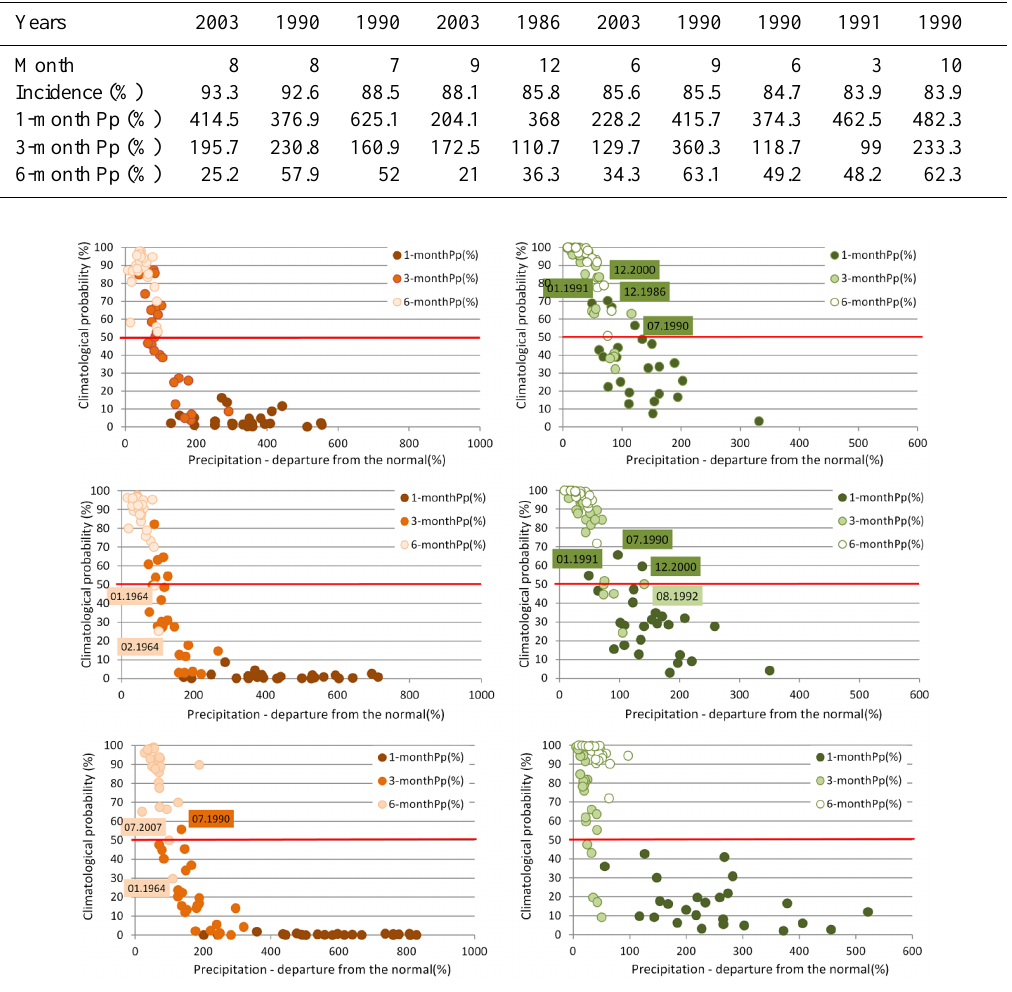
Figure 5. Probability (%) of ending (left) or ameliorating (right) moderate (top), severe (centre) and extreme drought (bottom) events with the highest incidence in the Carpathian region in the next 1, 3, 6